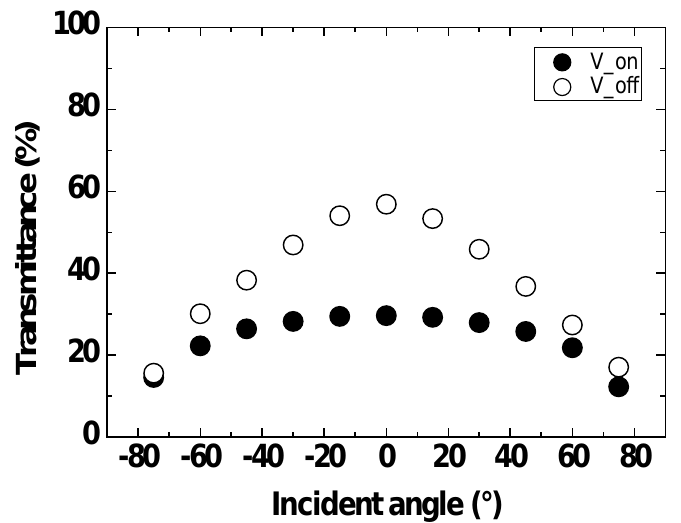
Figure 6. Measured transmittance of the fabricated GHLC cell vs. the incident angle in the ON and OFF states.